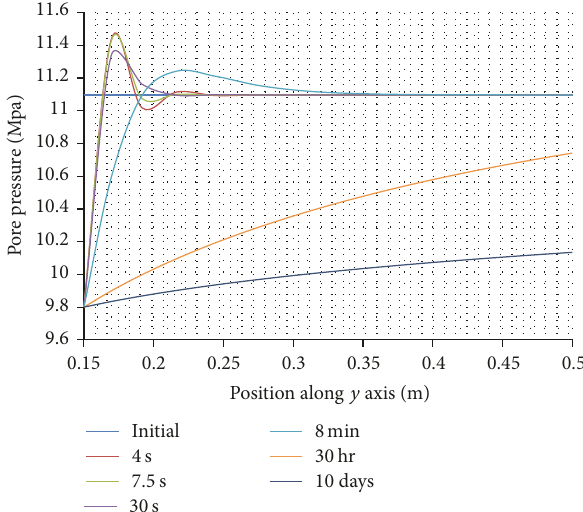
Figure 18: Pore pressure as a function of radius and time in poroelastic medium with 𝜎 𝐻 = 16.8 MPa and 𝜎 ℎ = 14 MPa, 𝑃 𝑟 = 11MPa, 𝑃 𝑤 = 9.7 MPa, 𝑘 𝑥 = 0.01md, 𝑘 𝑦 = 0.01md, and 𝑇 𝑚 = 300